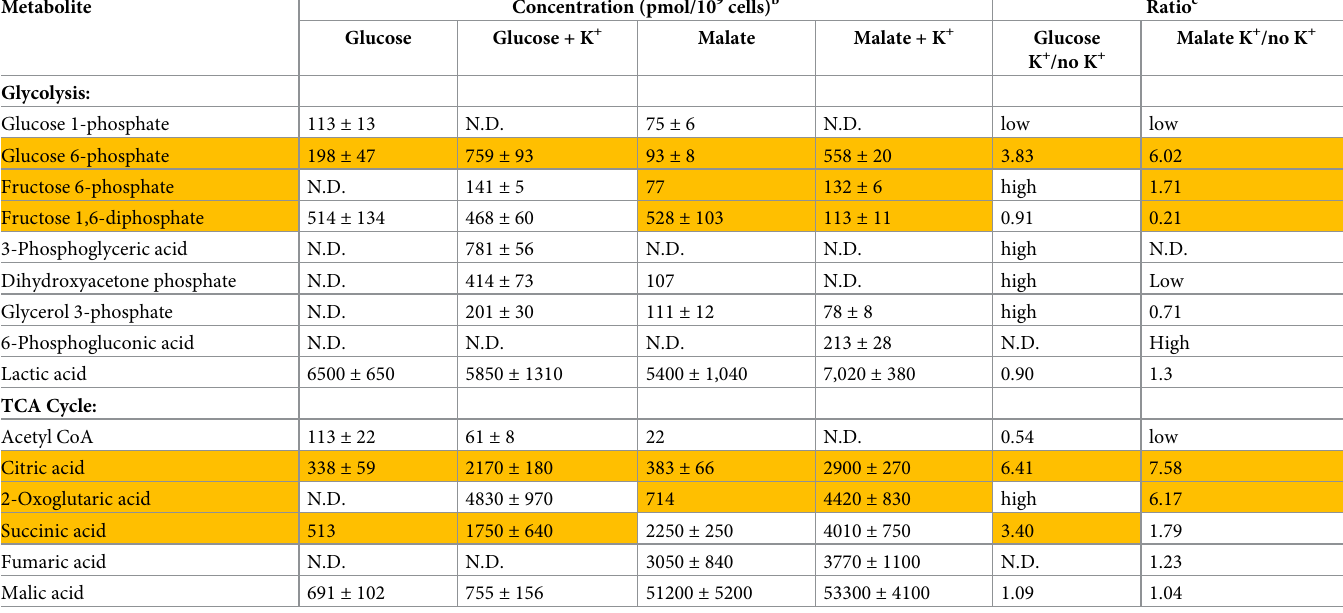
Table 6. Concentration of metabolites of glycolysis and the TCA cycle in wild-type cells in the absence or presence of 10 mM KCl a .